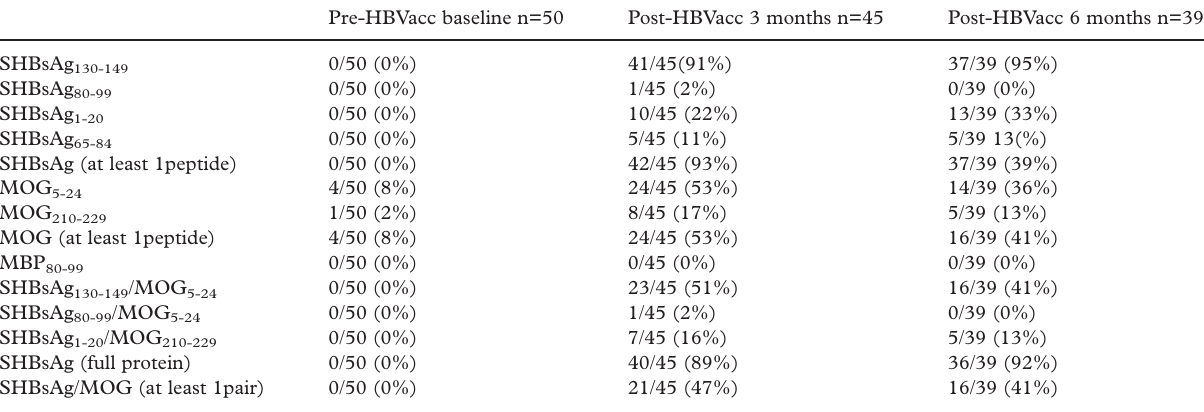
Table I. Single and double reactivity to SHBsAg and myelin mimics in absolute numbers and percentages (%), in 50 vaccinees before and after